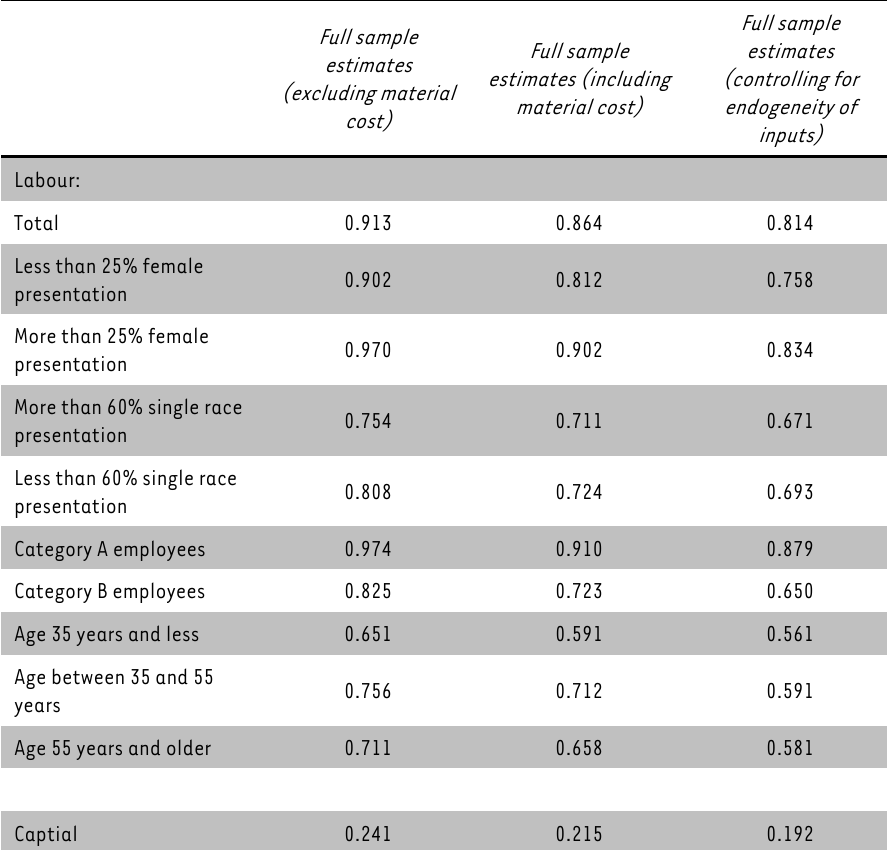
TABLE 1: Panel data estimates for the impact of in-house training on employee productivity (for the different diversity